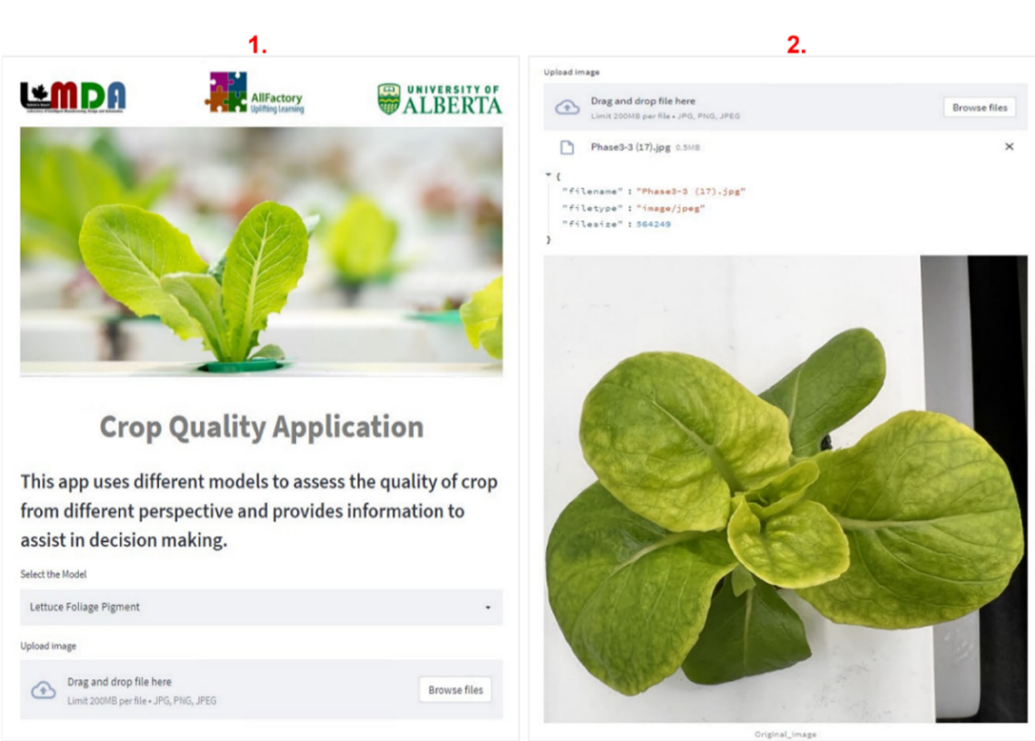
Figure A2. Stages 3 and 4 of cloud-based application. Figure A1. Stages 1 and 2 of cloud-based application.